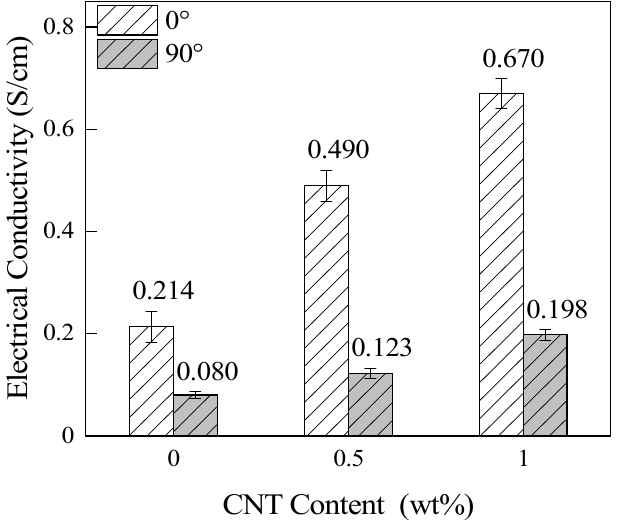
Figure 6. Electrical conductivity of the composites with different CNT contents in different CF directions.